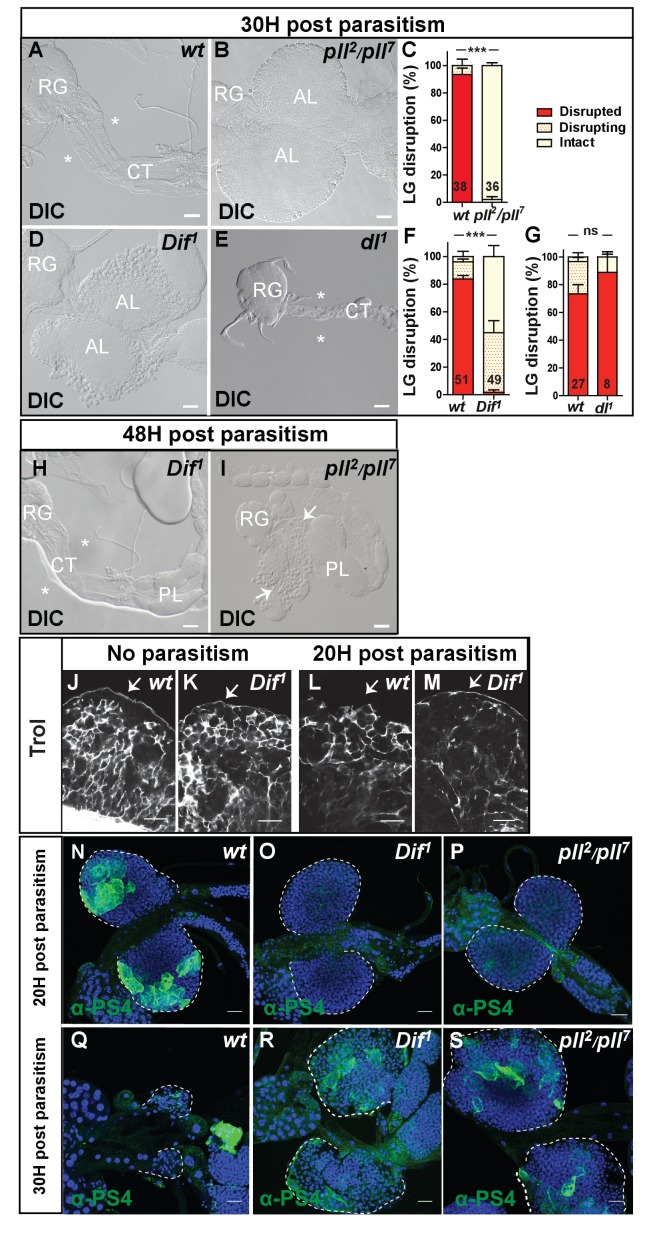
Dif-dependent Toll/NF-κB signaling is required for correct timing of lymph gland dispersal in response to wasp parasitism.(A, B, D, E) Differential interference contrast (DIC) microscopy of lymph gland anterior lobes 30 hr post-parasitism. Lymph glands were classified into three groups (see Materials and methods): Disrupted (*) in wt (wild type, (A) or dl1 mutant (E); intact in pll2/pll7 mutant (B); disrupting in Dif1 mutant (D). Representative lymph glands are shown. Ring gland, RG; cardiac tube, CT; anterior lobe, AL; posterior lobe, PL. (C, F, G) Quantification of lymph gland disruption (%). The error bars correspond to SEM, ***p<0.001 and ns (not significant) (Pearson’s Chi-squared test). In this and subsequent similar analyses, numbers of lymph glands analyzed are indicated on histograms. (H, I) DIC microscopy of lymph glands in Dif1 (H) and pll2/pll7 (I) mutants 48 hr post-parasitism. Disrupted (*) and disrupting (arrows) lymph glands are shown. (J–M) Perlecan/Trol (white) immunostaining in control (J, L) and Dif1 anterior lobes (K, M). (N–S) αPS4 (green) immunostaining labels lamellocytes in lymph glands in wt (N, Q), Dif1 (O, R) and pll2/pll7 (P, S) mutants. 20 hr post-parasitism, more than 65% (n = 24) of wt lymph glands displayed lamellocytes, whereas none (n = 24) or less than 15% (n = 18) contained lamellocytes in Dif1 and pll2/pll7 mutants, respectively. 30 hr post-parasitism, Dif1 and pll2/pll7 mutant lymph glands have lamellocytes, whereas most wt lymph glands have disrupted. In this and subsequent figures (unless specified), the scale bar represents 20 µm and nuclei are labeled with TOPRO3 or Draq5.10.7554/eLife.25496.005Figure 1—source data 1.Lymph gland disruption quantification.